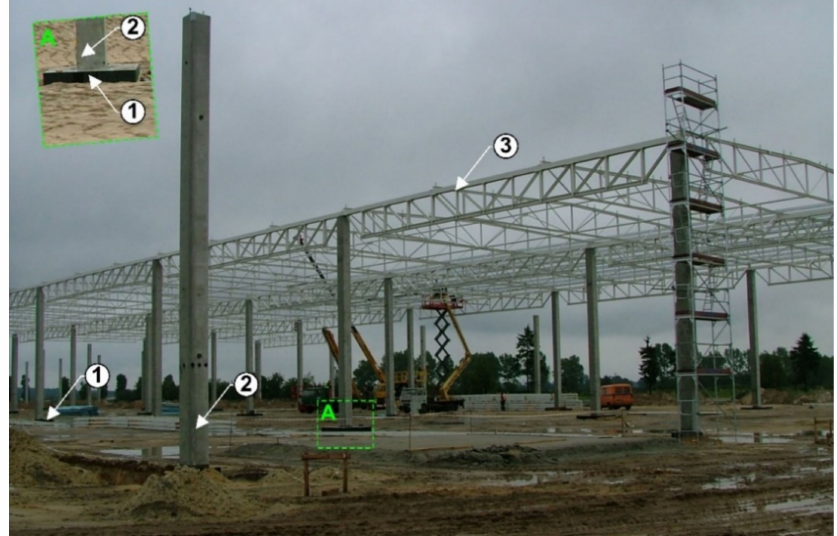
Figure 3. The skeleton of the hall building with PF during the assembly: 1,2,3, as in Figure 1; A, detail of the connection of an RC column with